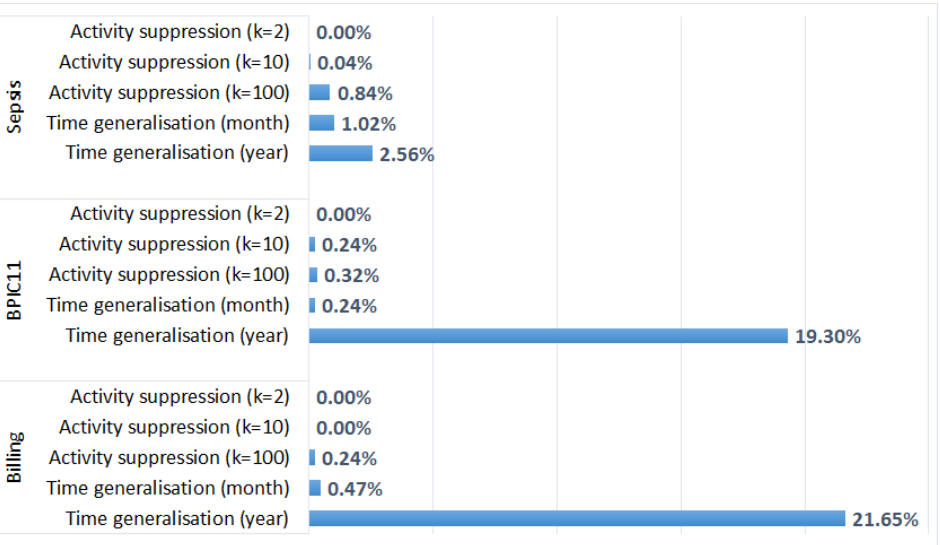
Figure 6. The impact of activity suppression and time generalisation on the results of process performance analysis: the absolute percentage differences between the average case throughput times in the anonymised logs and the corresponding original logs.